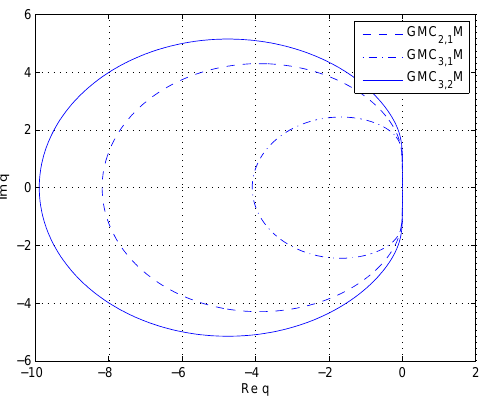
Figure 3. Linear stability region for GMC 2,1 M , GMC 3,1 M , GMC 3,2 M